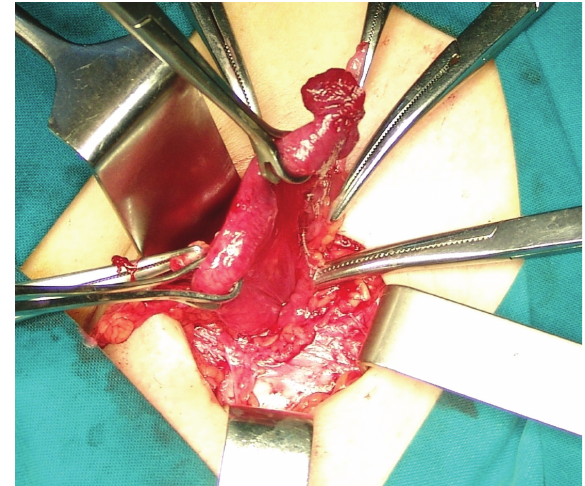
Figure 3: The uterine tube with its mesosalpinx, while the right ovary lies within the abdominal